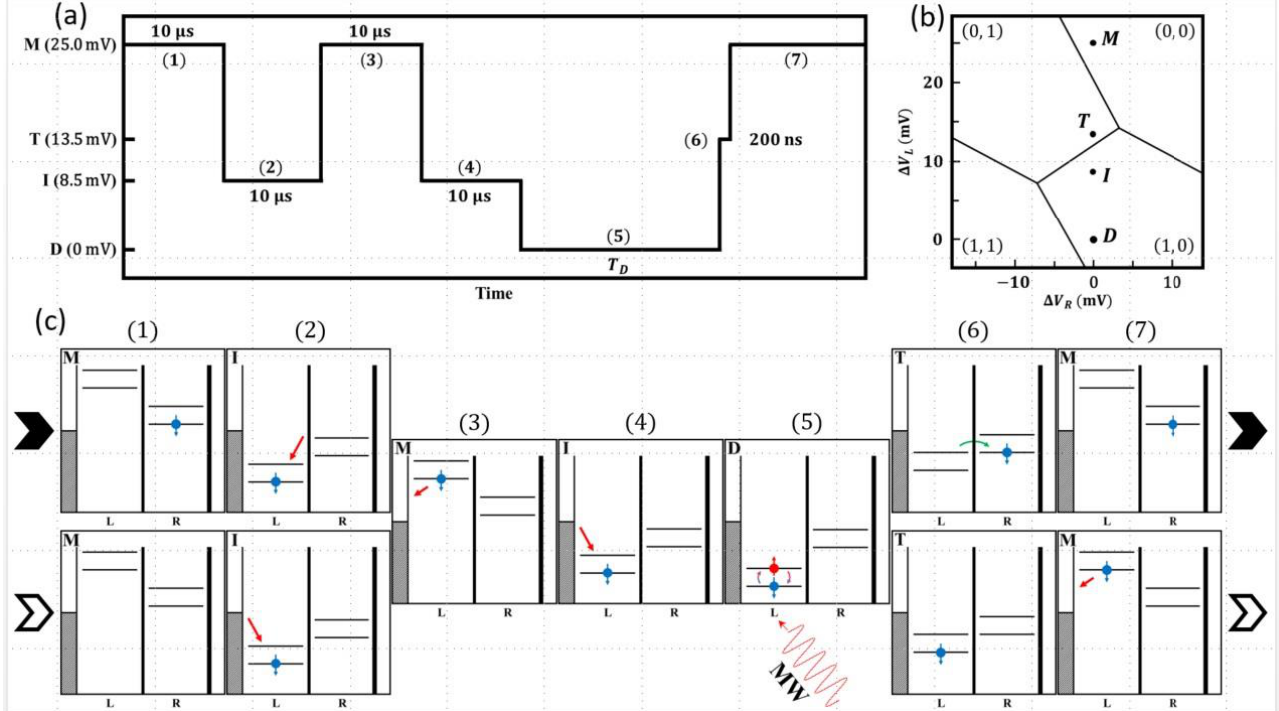
Figure 2. ( a ) The control pulse sequence used in the spin manipulation and read-out experiments. The steps are enumerated in brackets (N) in correspondence with the energy diagrams in ( c ). The left axis is given in millivolts of the control pulse stages labeled by a letter as measurement (M), transfer (T), initialization (I), and (D) Drive. The same letters are used in the diagrams ( b , c ). ( b ) A schematic of the stability diagram is shown in Figure 1b nb. The gate detuning voltages Δ𝑉 𝐿 and Δ𝑉 𝑅 are presented with respect to the drive point D. The vertical position of the stage points (D, I, T, M) match those marked in the Y-axis of ( a ). ( c ) The sequence of DQD energy diagrams with indicated occupations and transitions at each detuning point produced by the control pulse in ( a ). (For details see text).